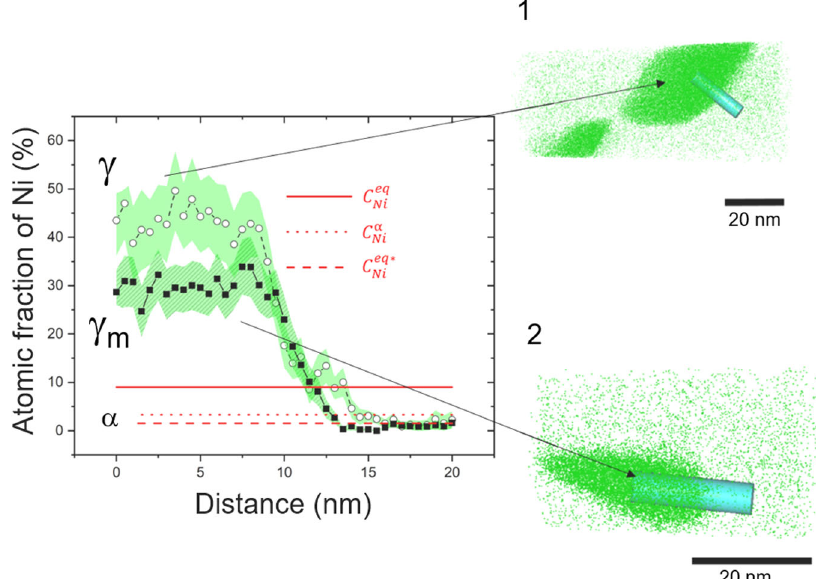
Fig. 4 Identi fi cation of a low-Ni metastable phase γ m . APT reconstructed volumes from the Fe-3.3 at% Ni material. 1D-composition pro fi le along with the cylinders at the interface between the α and γ phases extracted from two precipitates. Green shaded areas represent the statistical error associated with the measurement of the composition. The Ni equilibrium and metastable solubility limits, and the nominal Ni composition are respectively shown in solid, dashed, and dotted lines. Compositions of precipitates 1 and 2 are close to the ones of γ and γ m phases